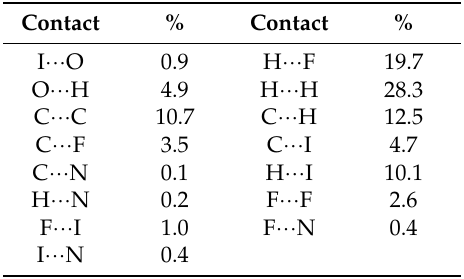
Figure 7. Two-dimensional fingerprint plots for the cocrystal ( a ) and O···I / I···O interaction ( b ). Table 3. Contributions of the intermolecular contacts.